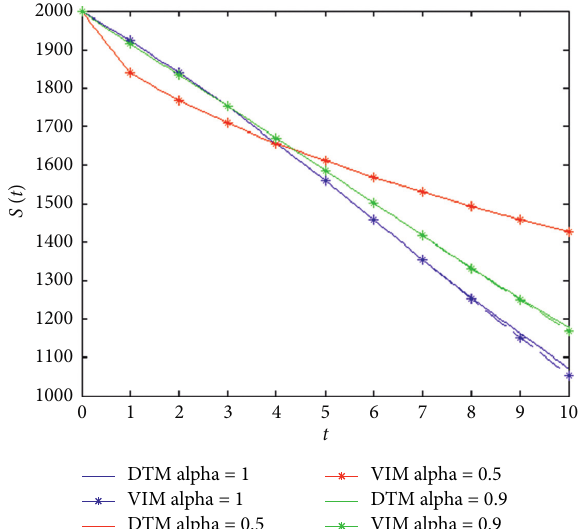
Figure 1: Comparison of VIM solutions with the CDTM solutions of S ( t ) for system (10) at different α